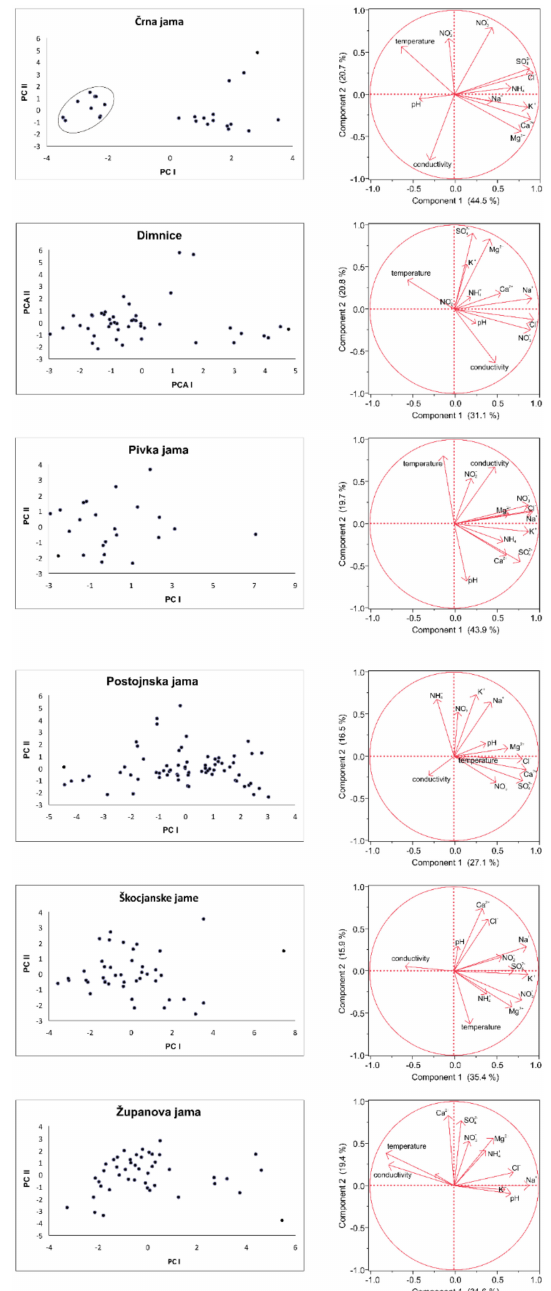
Figure 2. PCA analysis by cave. On the left hand panels, individual samples are shown. For ˇCrna jama, the ellipse encloses all samples taken during October and November. It was the only such cluster of sampling dates for the six caves. See text for details. On the right hand panels the eigenvectors for the physical and chemical variables are